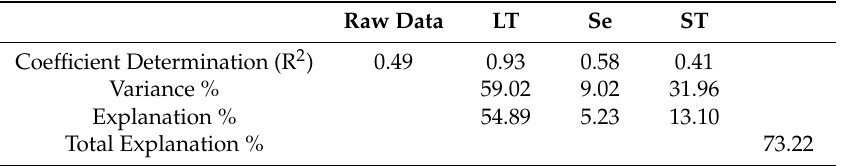
Table 6. The first row describes the coefficient of determination (R 2 ) of the TSR model for the long, seasonal, and short-term component of the water discharge data. The second row describes the percent of the variance contributed in each component. The third row is the percent of explanation described for each component, and the fourth row is the total explanation of the TSR